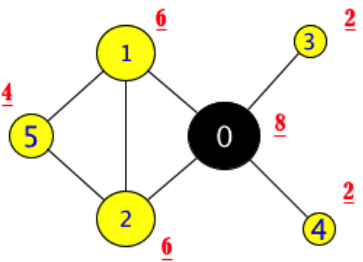
Figure 2. A graph and the upper bound for each node in red underlined text. The bound has been calculated using the Theorem 2 for α = 0.5. For node 0, the bound B ( 0 ) = 8 cannot be achieved, since this requires that all of its neighbors be members of a community of size 8, whereas all of the nodes in the neighborhood have a bound smaller than